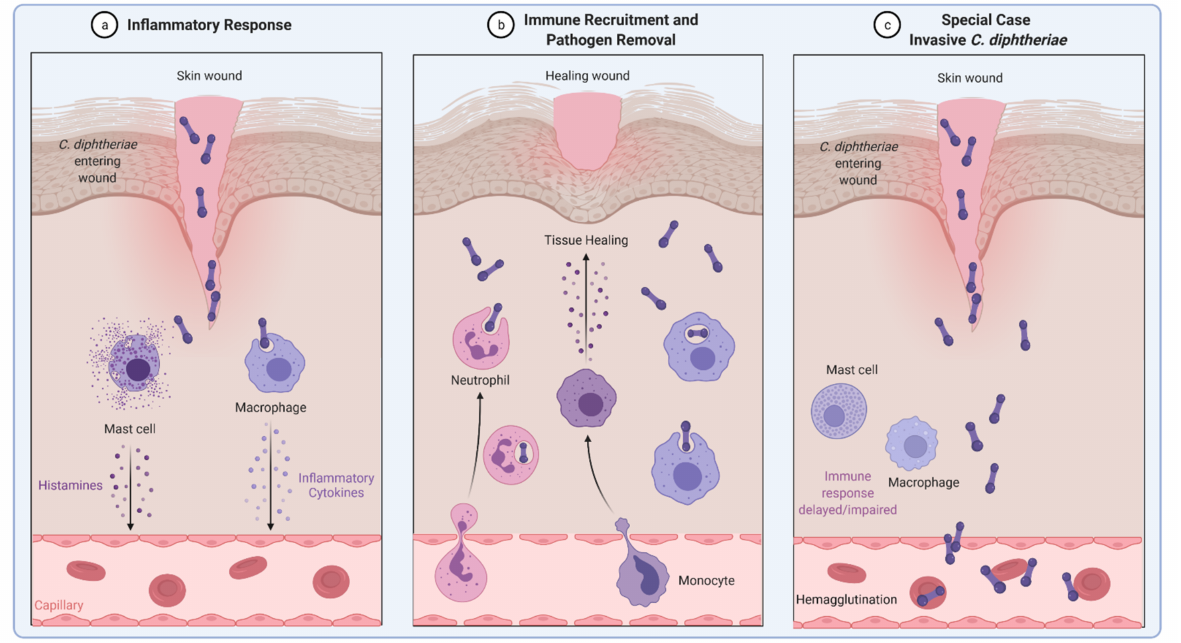
Figure 3. Inflammatory response induced by C. diphtheriae . ( a , b ) Inflammatory response caused by non-invasive C. diphtheriae . Entering bacteria lead to recruitment of immune cells such as neutrophils and macrophages and removal of the pathogen. ( c ) Invasive C. diphtheriae remain undetected by the host immune system through unknown mechanisms, gain access to deeper tissues and blood vessels, and spread through the whole body by binding erythrocytes (hemagglutination) (figure created with